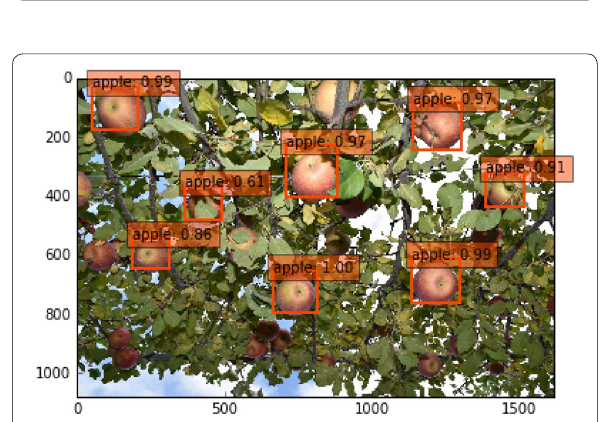
Fig. 8 Result of detection1